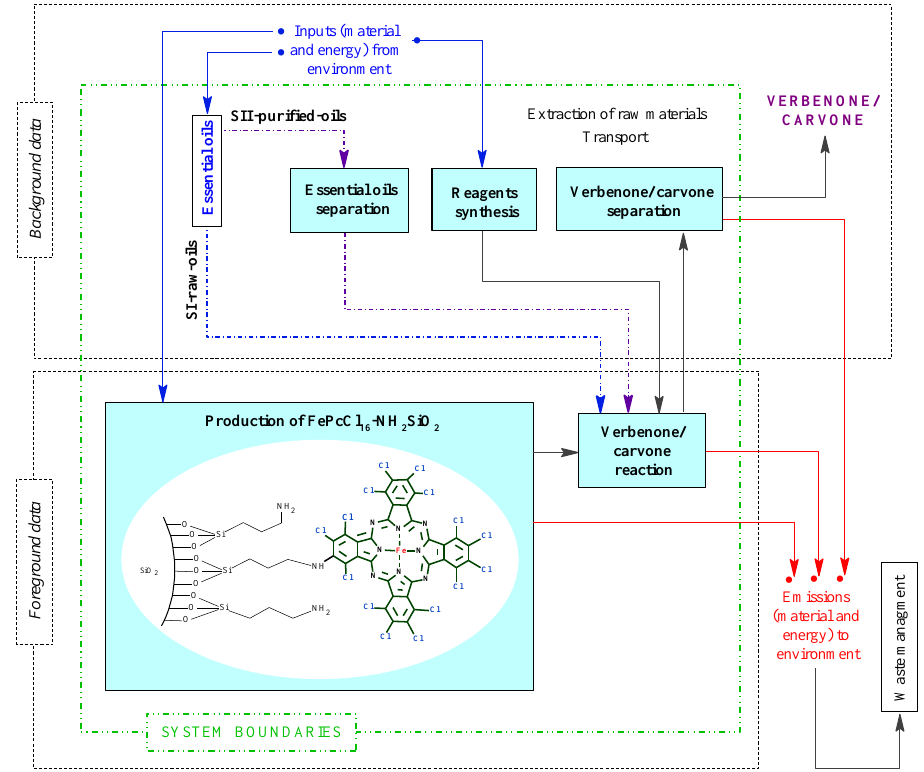
Figure 3. System boundaries corresponding to the scenarios in the LCA for verbenone and carvone production. Scenario I (SI-raw-oils), Scenario II (SII-purified-oils).